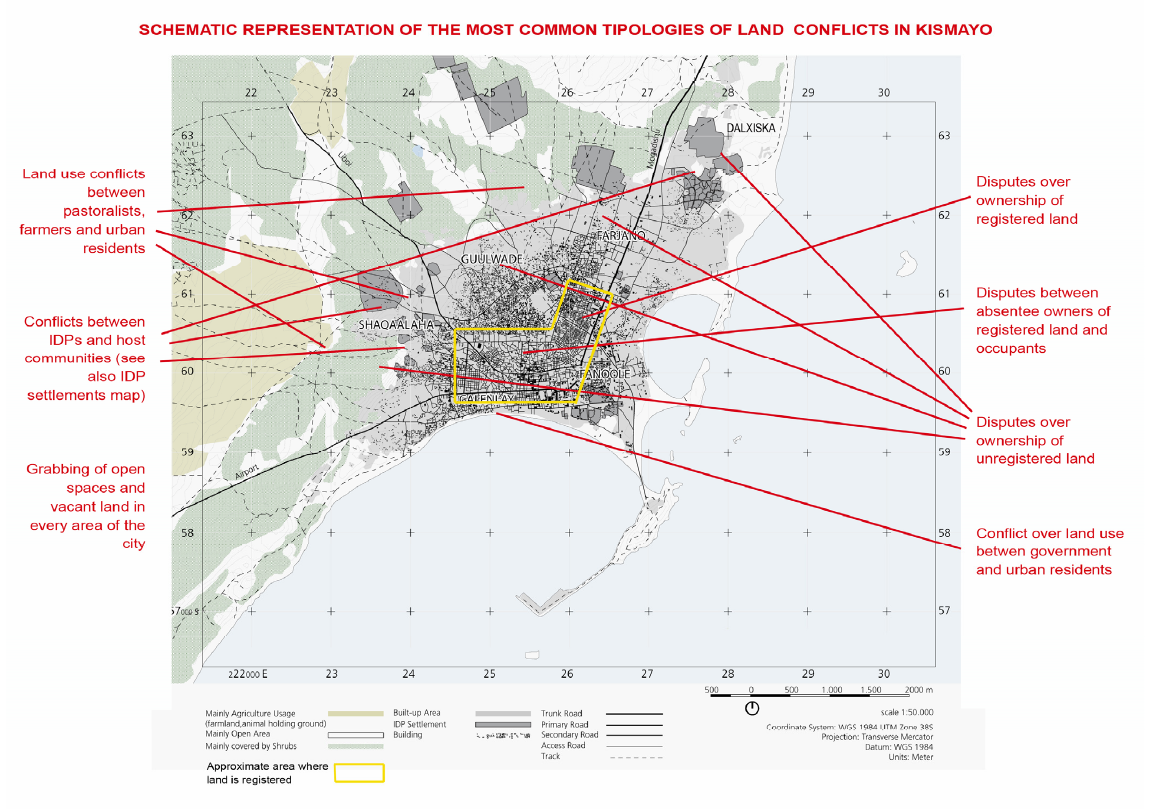
Figure 2. Analysis of the land-related root causes of conflict in Jubaland [9], (p. 48); copyright UN-Habitat.